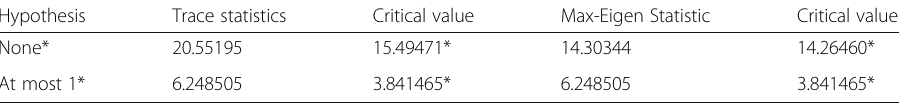
Table 5 Johansen cointegration test results